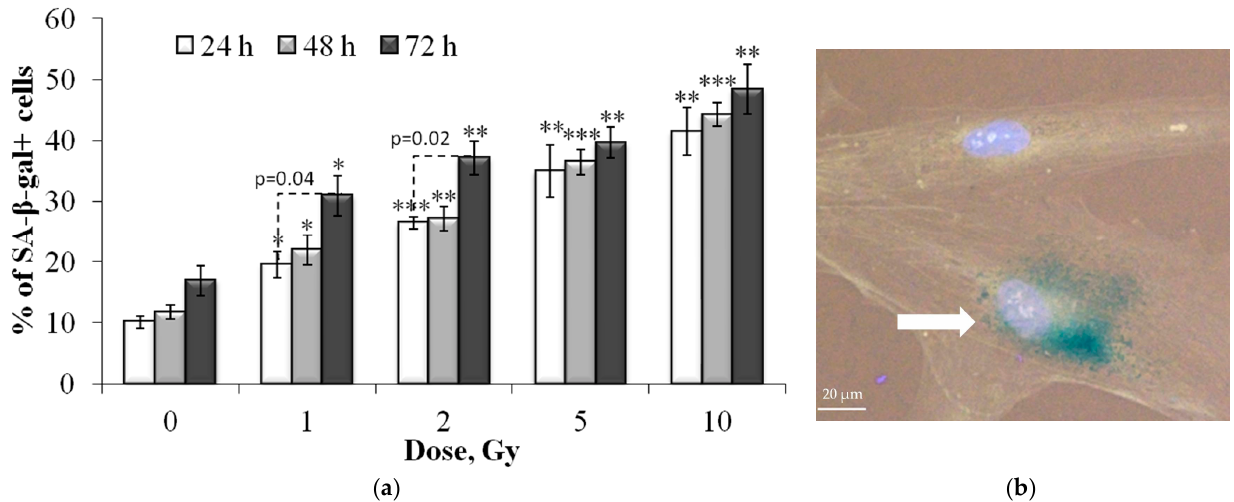
Figure 6. ( a ) Dose-dependent changes in the senescent cell (SA- β -gal+) proportion in human fibroblasts 24 h, 48 h and 72 h after irradiation. Data are means ± SE of three independent experiments. * p < 0.05, ** p < 0.01 and *** p < 0.001—compared with the corresponding time of control; ( b ) Representative image of the SA- β -gal positive cell (marked with arrow—cytoplasm colored in dark green-blue). Nuclei are counterstained with Hoechst 33342 (light blue).